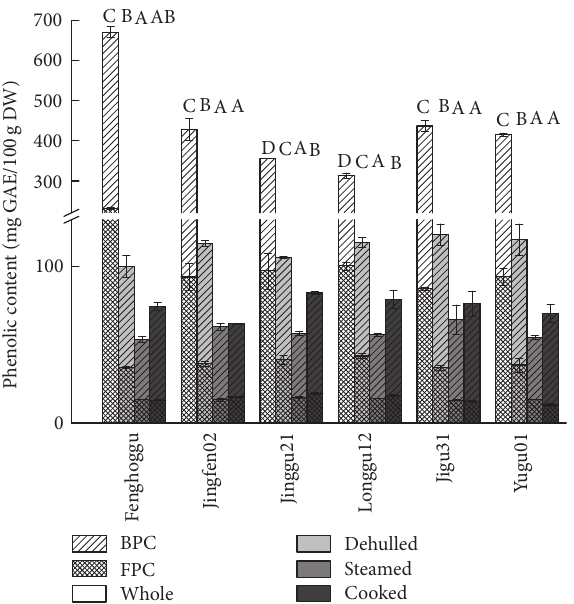
Figure 1: The FPC, BPC, and TPC of 6 cultivars of foxtail millet with different treatment. Error bars represent the standard deviation ( ± SD). The different uppercase letters (A–D) indicate significant differences of TPC within different processing methods of the same cultivar ( 𝑃 < 0.05